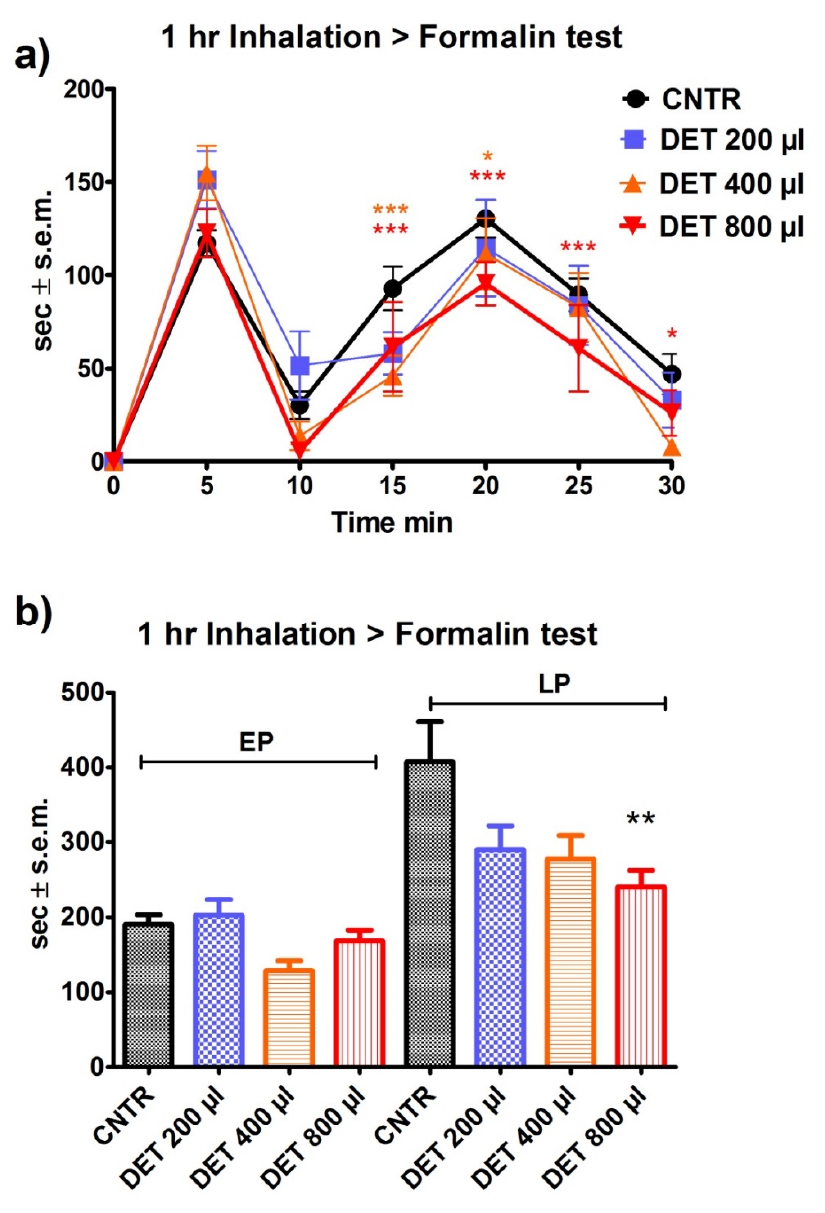
Figure 6. Effect of the one-hour pre-treatment with the deterpenated fraction (DET) of bergamot essential oil (BEO) on 2% formalin-induced licking/biting behavior. ( a ) Time course based on seconds (sec) of licking/biting recorded at intervals of 5 min and expressed as time in sec ± S.E.M. ( b ) Overall licking/biting time expressed as time in sec ± S.E.M. during the first phase (EP, 0–10 min) and the second phase (LP, 10–30 min). Two-way ANOVA followed by Bonferroni test; n = 8, * p < 0.05, ** p < 0.01, *** p < 0.001.